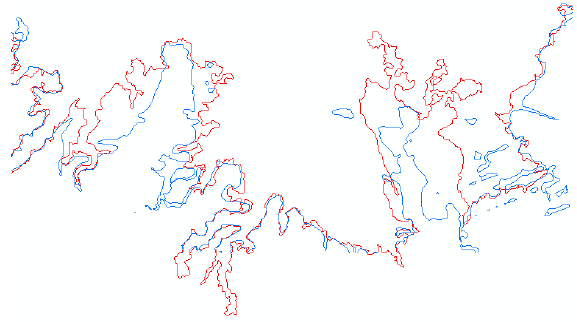
Figure 12. Edited contour line from DTM